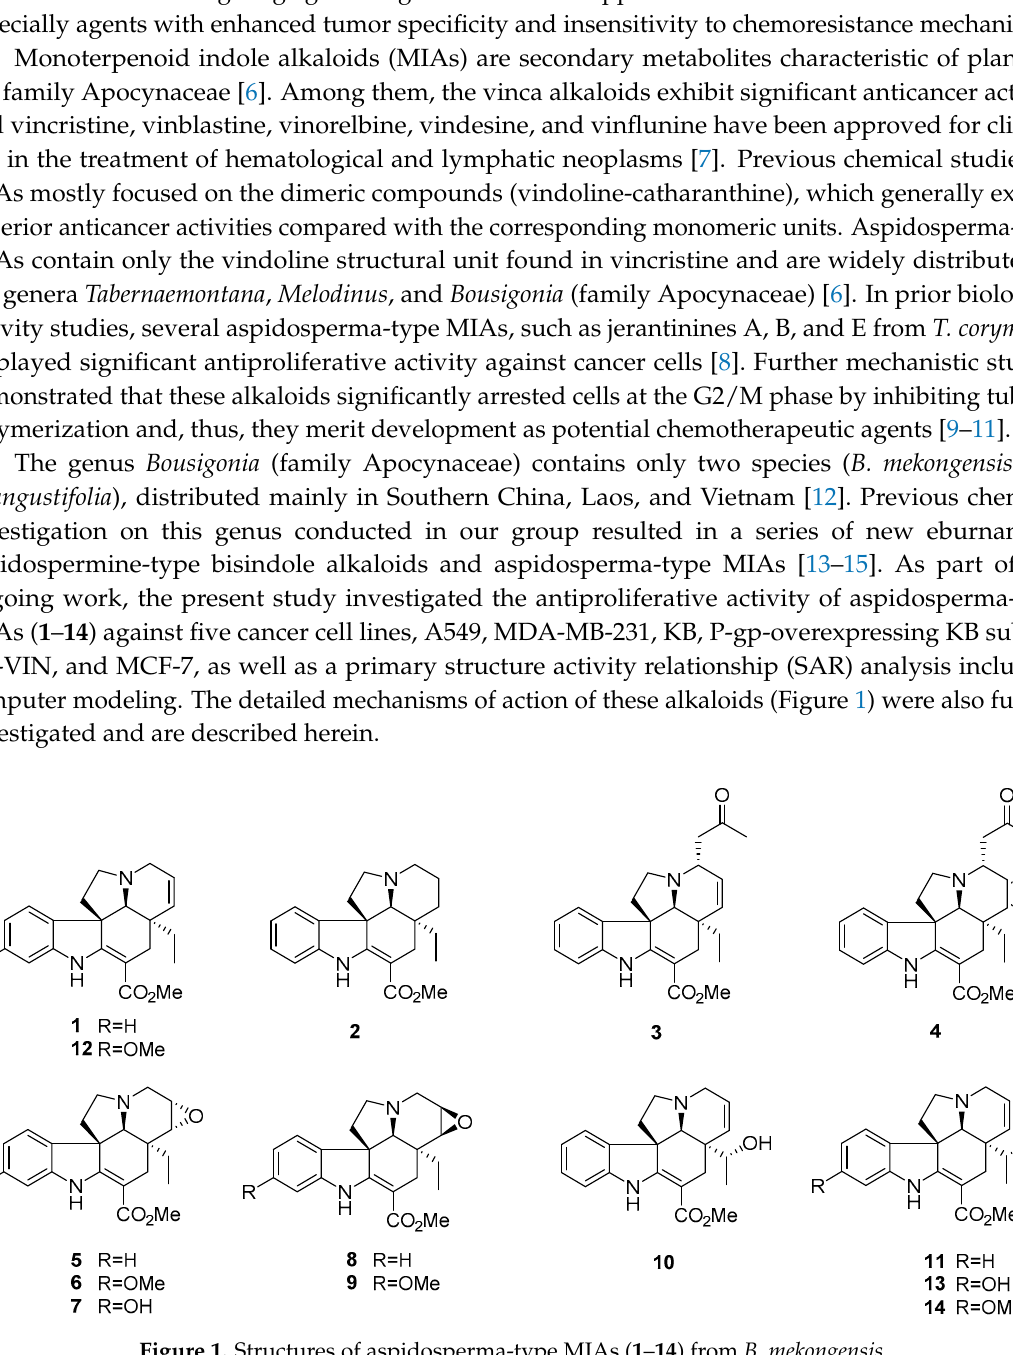
Figure 1. Structures of aspidosperma-type MIAs ( 1 – 14 ) from B. mekongensis .